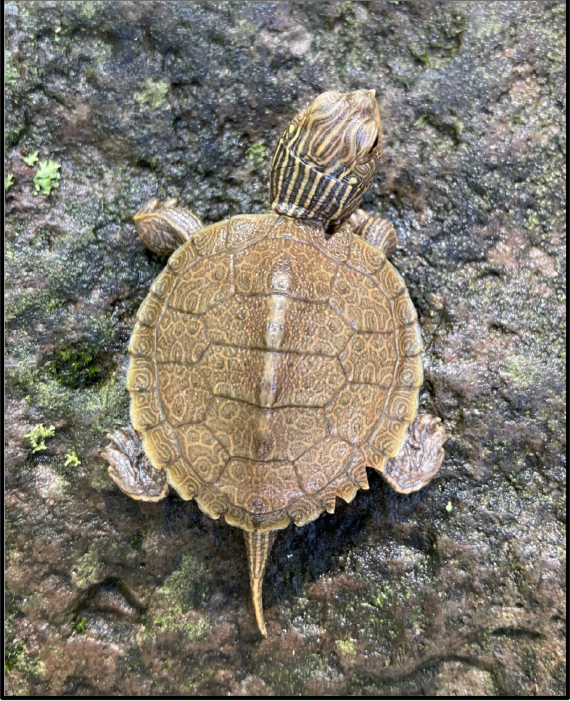
Figure 2. Hatchling Northern Map Turtle marked AIJ by notching three marginal scutes with iridectomy scissors. The first right marginal scute is always “A”, following Nagle et al.